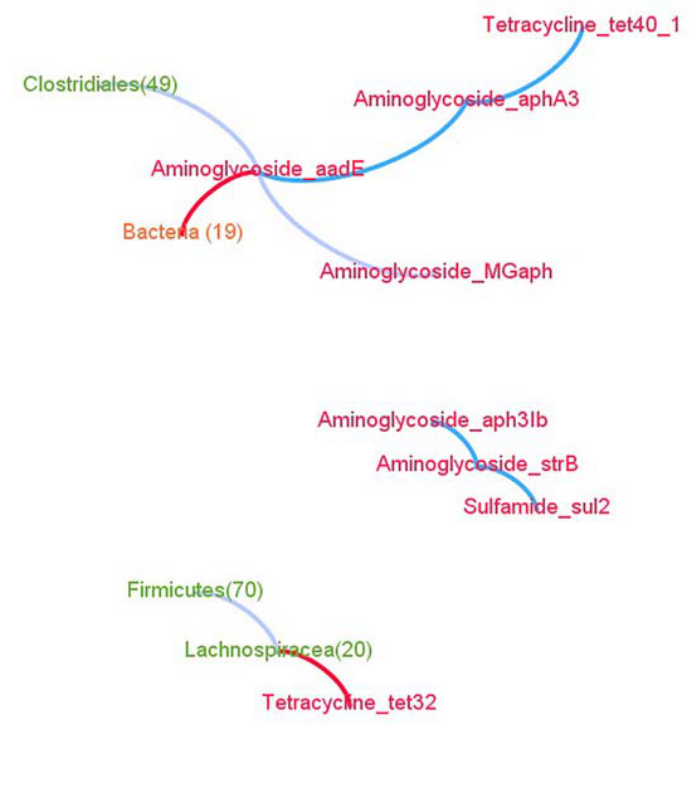
FIGURE 3 | Network of the significant linear (blue edges) and non-coexistence (red edges) associations between ARGs (red nodes) and OTUs. Unclassified associations are in